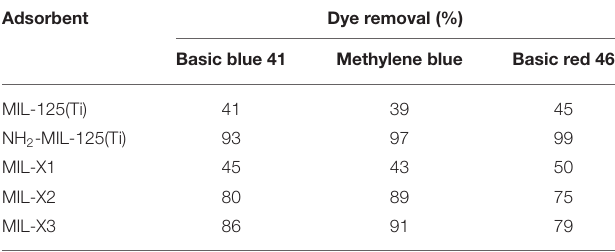
TABLE 2 | Dye removal using Materials Institut Lavoisiers (MILs).